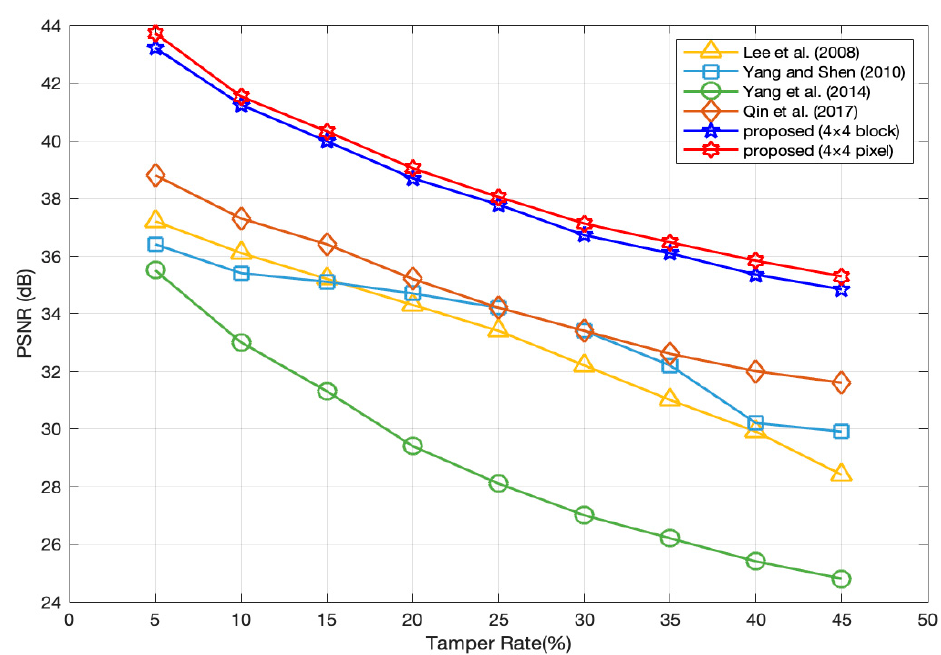
Figure 10. Peak signal to noise ratio (PSNR (r) ) comparison of the recovered image between the proposed methods and methods in [20–22,31].